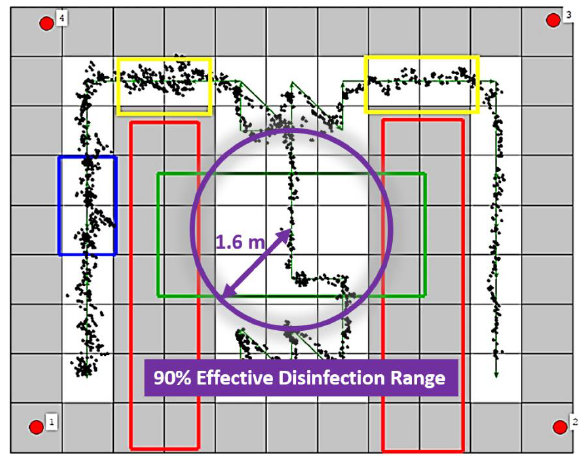
Figure 14. Disinfection coverage at a point.